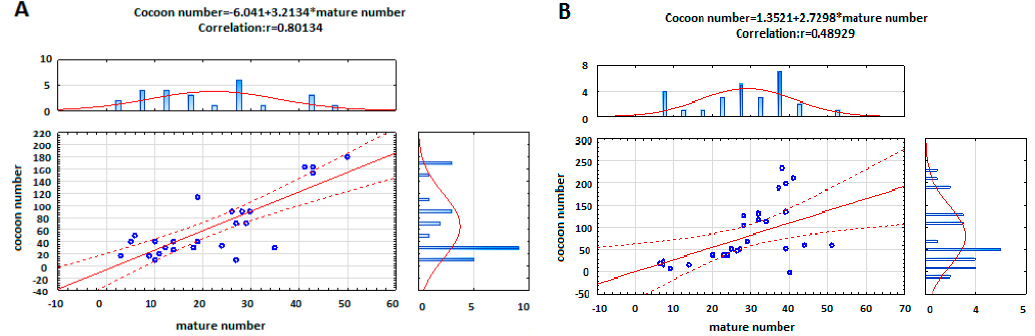
Figure 6. Correlation between the number of mature earthworms and number of produced cocoons ( X ± 0.95 confidence interval): ( A ) Control, ( B ) Owinema bio-preparation (50 mln larvae m − 2 ).